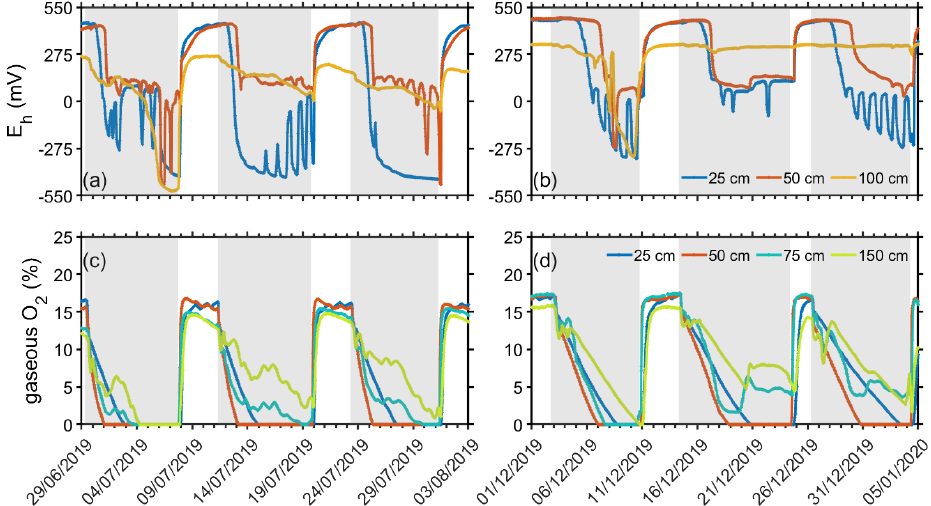
Figure 4. Representative time series of redox potential ( E h ) and gaseous O 2 measurements obtained at station 2 (Fig. 1) at depths of 25, 50, and 100cm. (a, c) Summer and (b, d) winter results are shown. Note that the grey and white areas indicate wetting and drying periods, respectively.